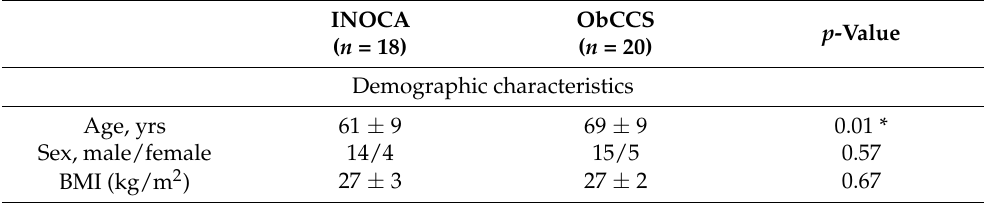
Table 3. Baseline characteristics of the study